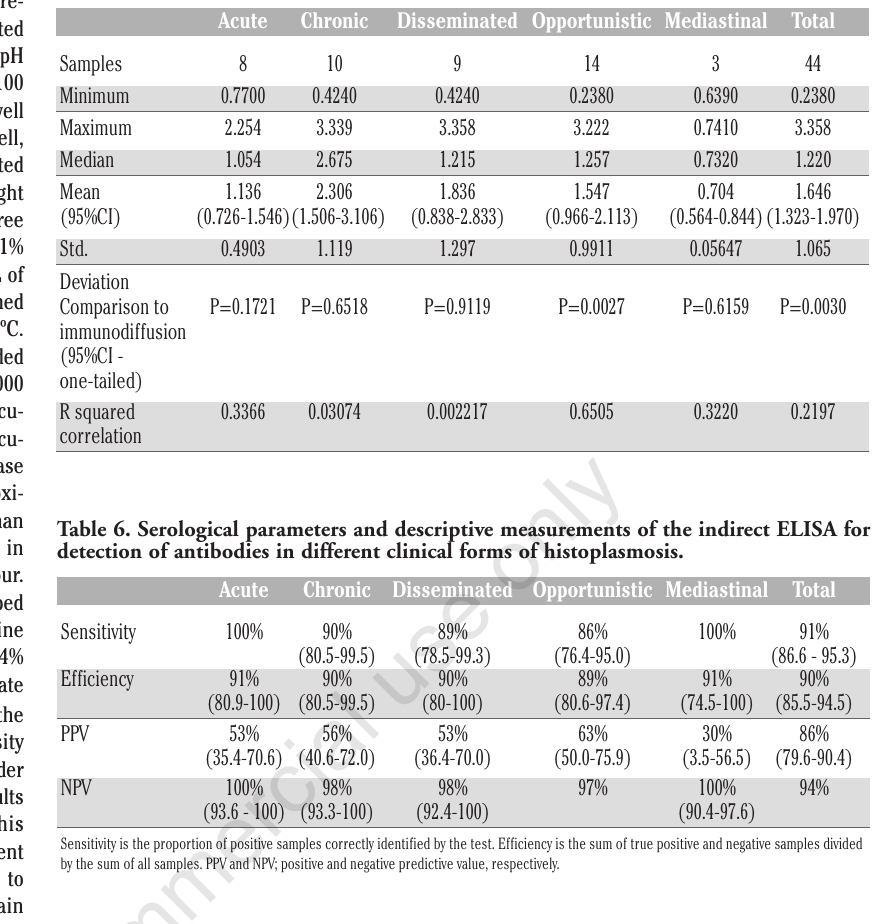
Table 5. Statistical parameters and descriptive measurement of the ELISA for detection of antibodies against ptHMIN: comparison of the different clinical forms of the disease (P>0.05).